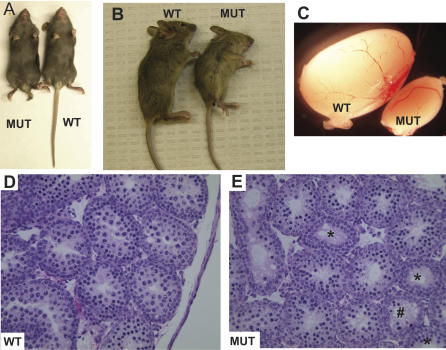
Developmental Phenotypes of Trip13 Mutant Mice(A) Shown are 21-d-old littermates. Note the shortened tail in the mutant, but overall similar body size.(B) Shown are 23-d-old littermates. The mutant is smaller in this case, but the tail is not as truncated as the mouse in (A).(C) Wild-type (WT) and homozygous Trip13 mutant (MUT) testes.(D) and (E) are cross sections through 17.5-d-old heterozygous (“WT”) and homozygous mutant Trip13 testes, respectively. Whereas the tubules in WT show coordinated spermatogenesis with pachytene spermatocytes present in all tubules (proximal to the lumen), developmental progression in the mutant is not synchronized between tubules. Some tubules have no pachytene spermatocyes (asterisks), while in others, development is somewhat disorganized (#).